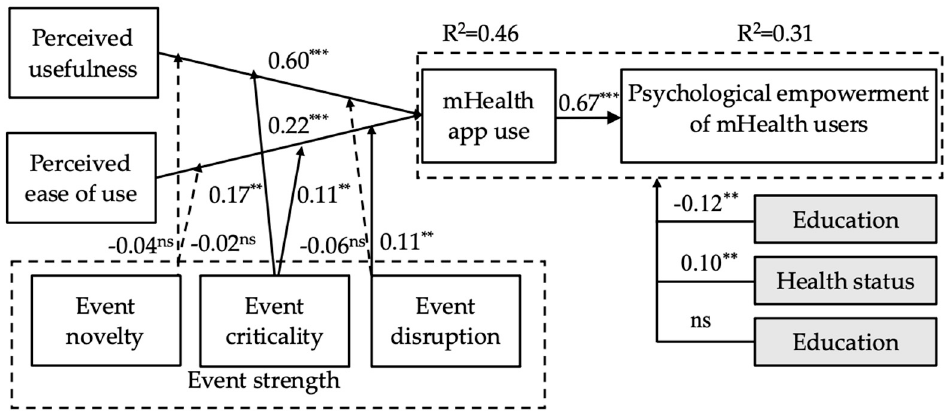
Figure 2. Results of the Research Model Assessment. Note: ** p < 0.01, *** p < 0.001, ns: not Table 4. Results of the Hypothesis Testing.